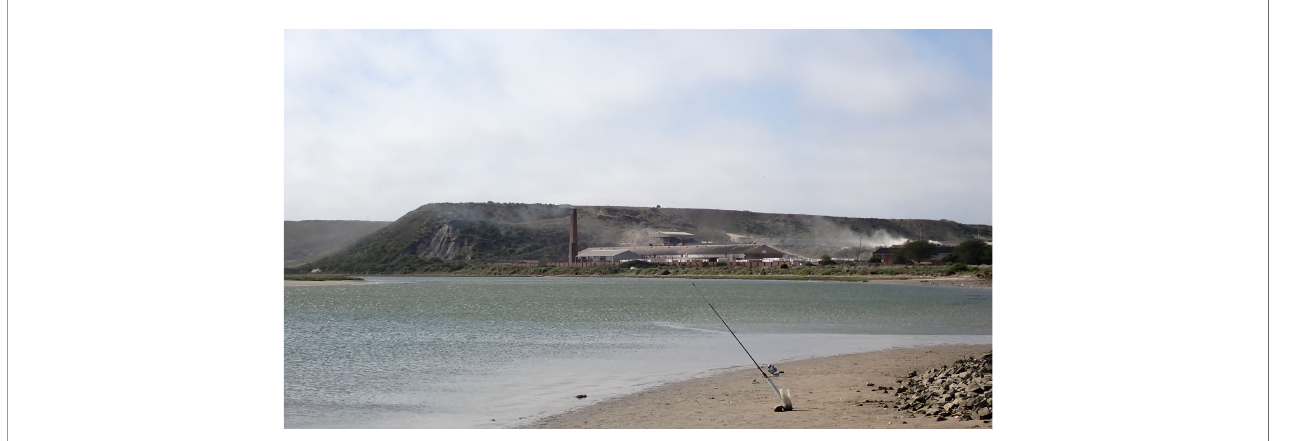
FIGURE 11 | Factories on the banks of the Swartkops River, near Aloes Community, contribute to industrial waste into the river where resident Francis Nkaki fi shes and collects bait.